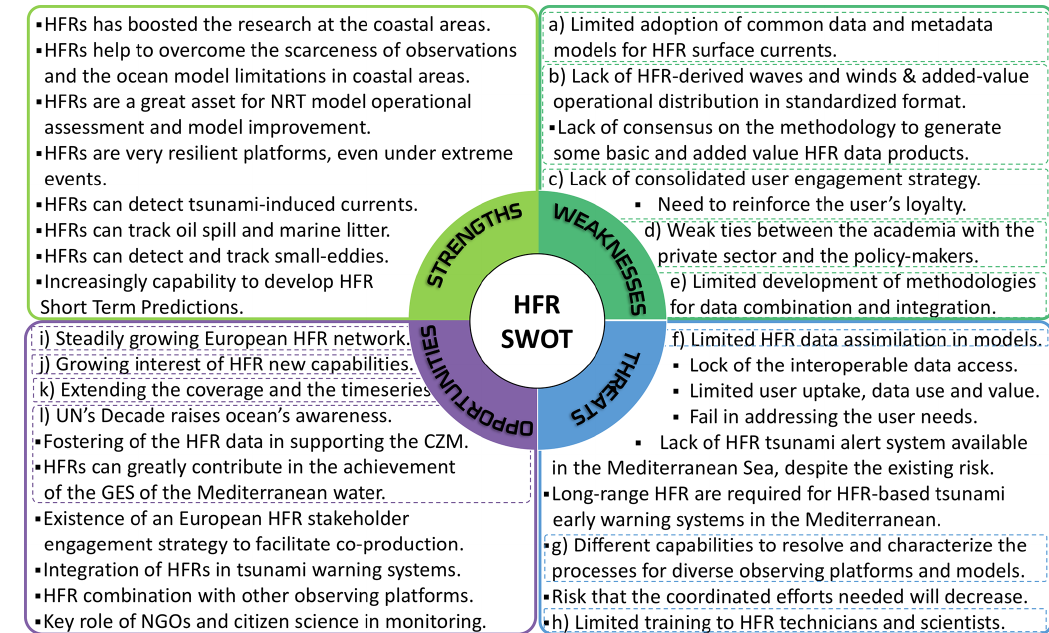
Figure 17. SWOT analysis of the HFR capabilities and applications. Dashed-line boxes around the text highlight those weaknesses, threats and opportunities that have been addressed in the